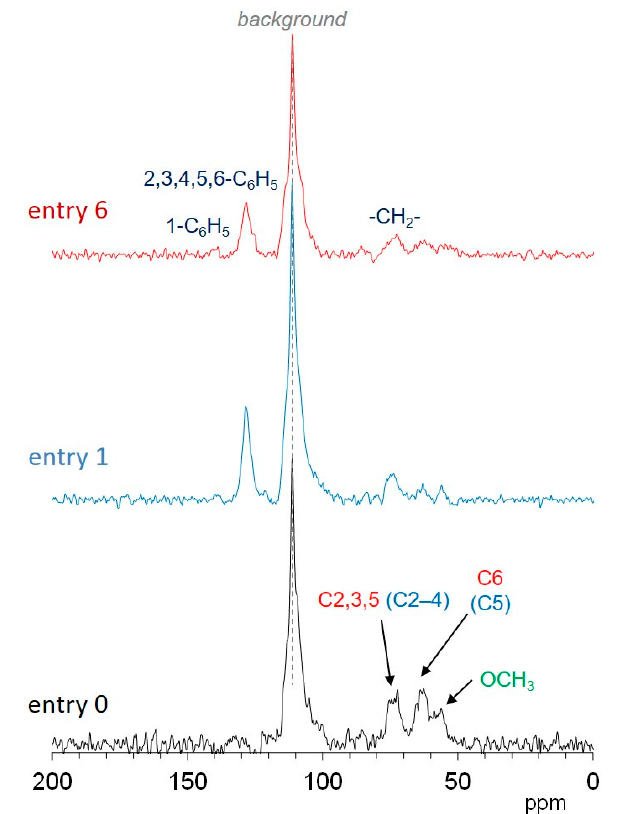
Figure 6. 13 C PST-MAS NMR spectra of degreased wood (entry 0, black) and benzylated woods (entry 1, blue; and entry 6, red).